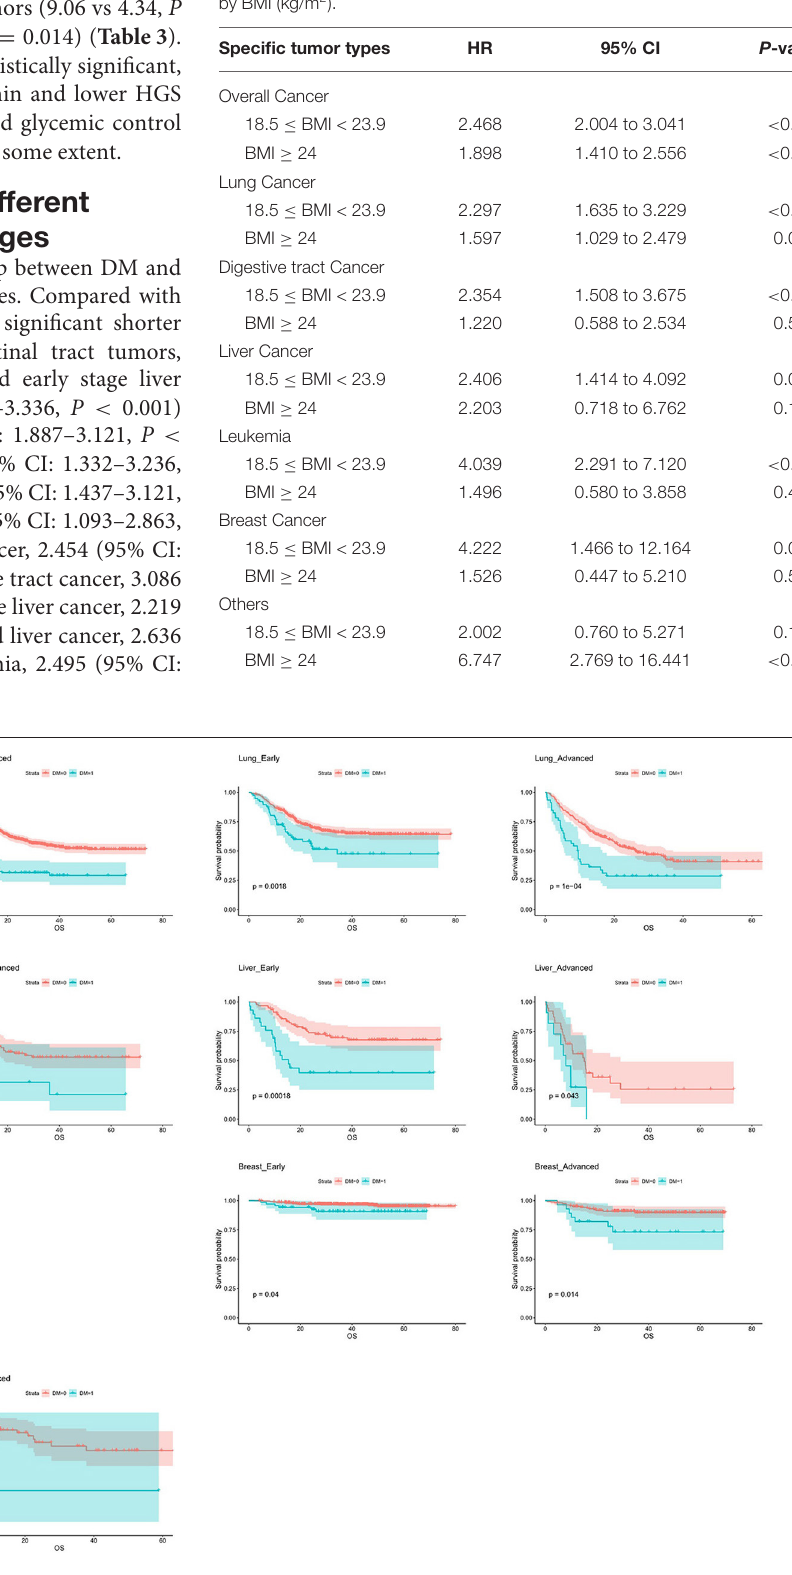
FIGURE 1 | Kaplan–Meier curves of overall survival in different cancer types stratified by stage. DM, diabetes mellitus.